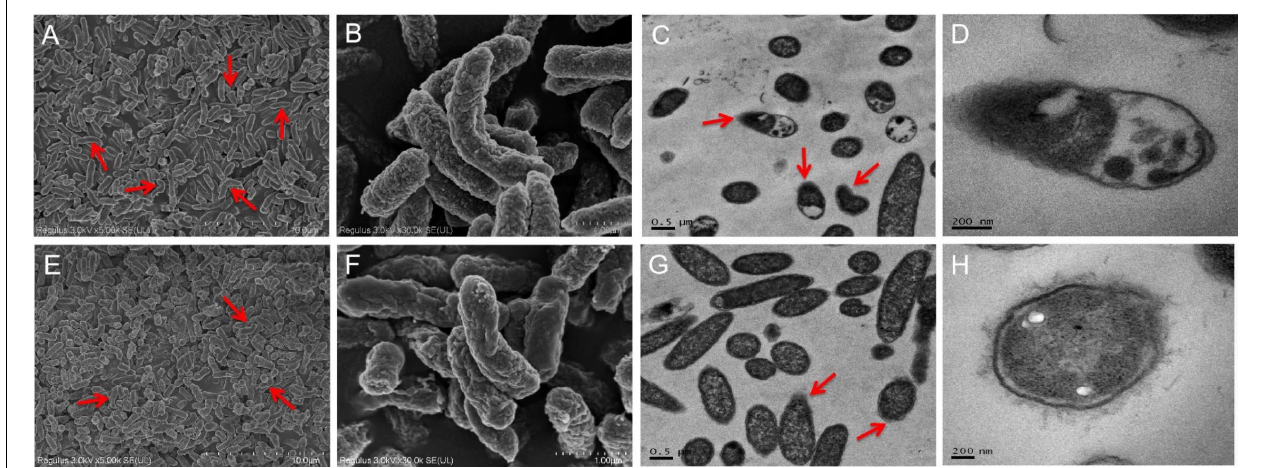
FIGURE 4 | SEM and TEM photomicrographs of S. Enteritidis CVCC 1806 (A–D) and S. Enteritidis S2002-13 (E–H) after treatment with 100 mg/L NaClO for 30 min. The red arrows indicate regions of bacterial cell damage.